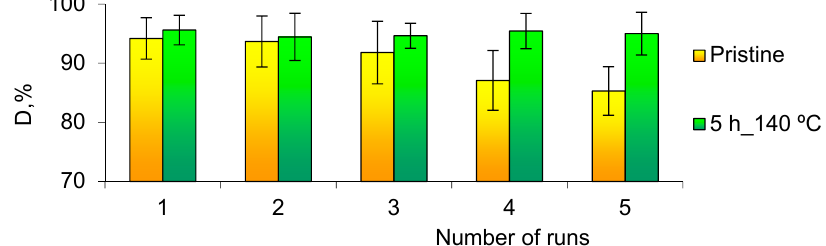
Figure 9. E ffi ciency of pristine and annealed (140 ◦ C, 5 h) composite membranes in 5 sequential cycles Figure 9. Efficiency of pristine and annealed (140 °C, 5 h) composite membranes in 5 sequential of reduction of